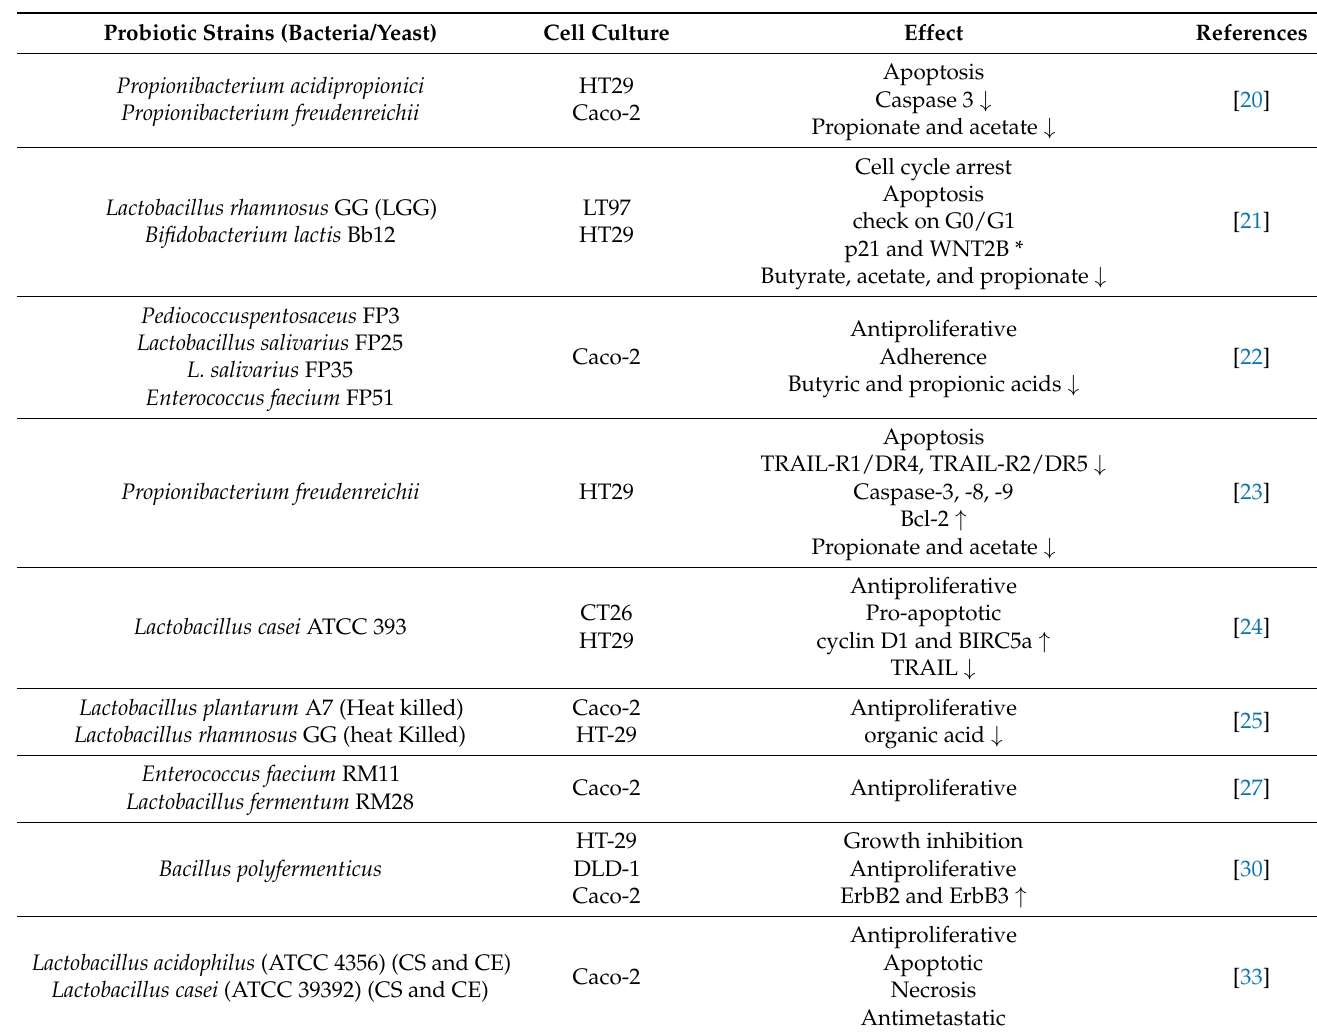
Table 1. Different probiotic strains and their effect on different cell lines in